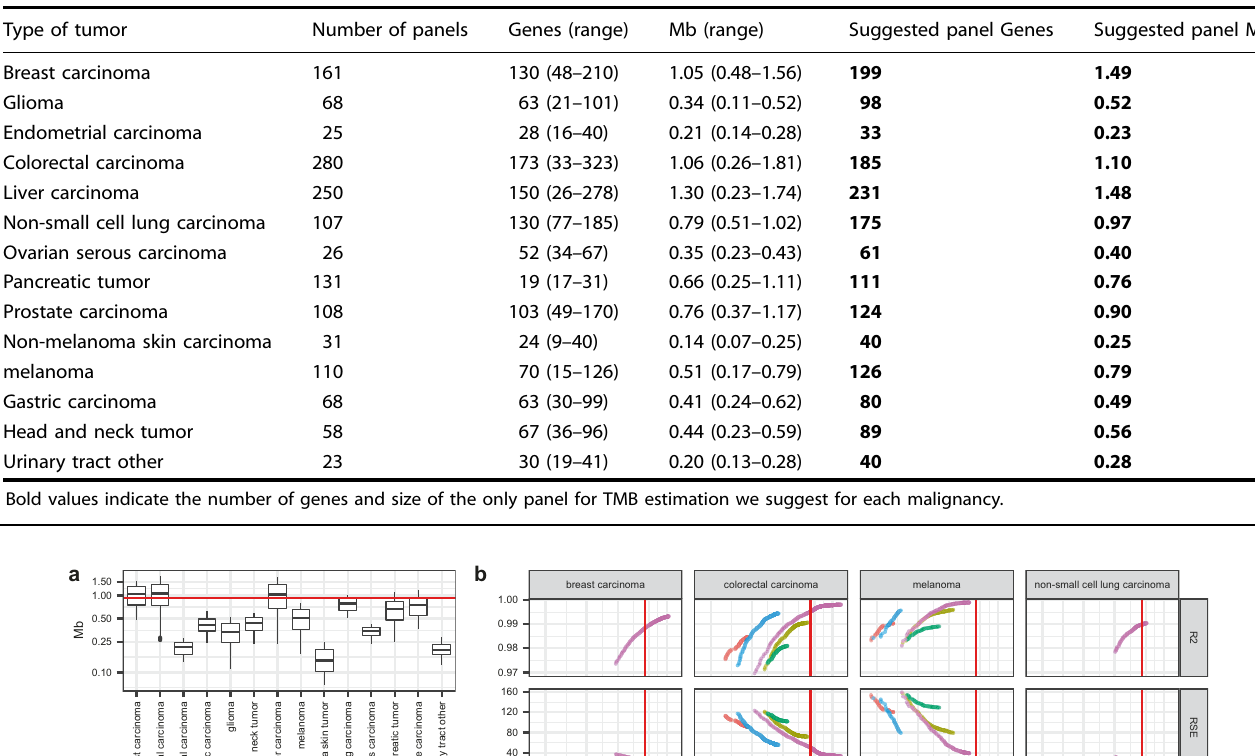
Table 1. Characteristics of the total (left) and suggested panels (right, bold) for accurate prediction of TMB in 14 cancer types.